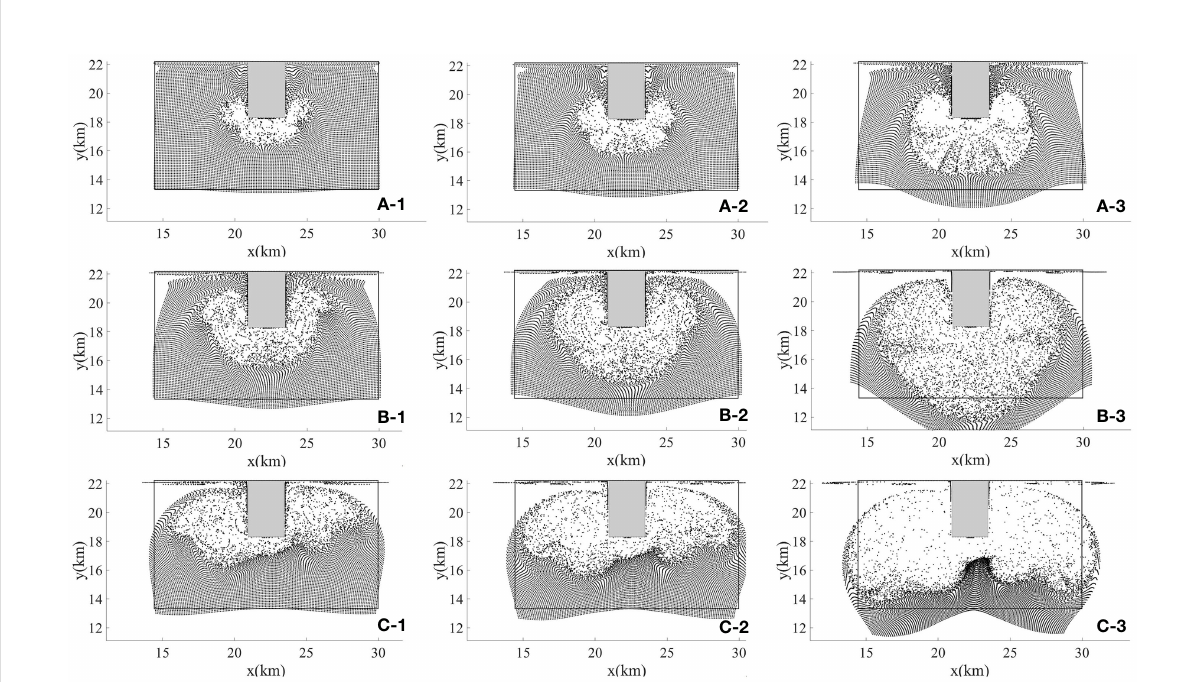
FIGURE 4 Particle distribution after t = 60 h (A-1, B-1, C-1), 120 h (A-2, B-2, C-2), 360 h (A-3, B-3, C-3) Under the action of three different fl ow velocities V0 = 0.1 m/s (A) , 0.3 m/s (B) , and 0.5 m/s (C) ,. The box with black lines is the initial release area of the